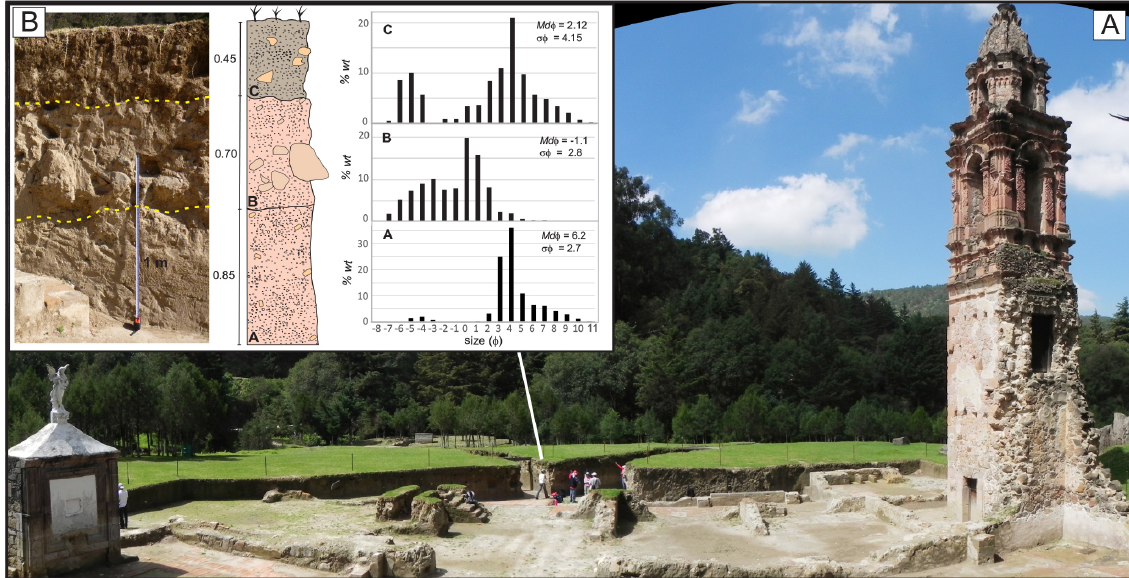
Figure 12. (a) Panoramic view from the east of the remains of El Carmen church buried by the tailings flood deposit (section TL-01). The excavation of the church remains exposed the ancient floor of the sanctuary. (b) Stratigraphic column showing three beds separated by dashed yellow lines and their granulometric bimodal